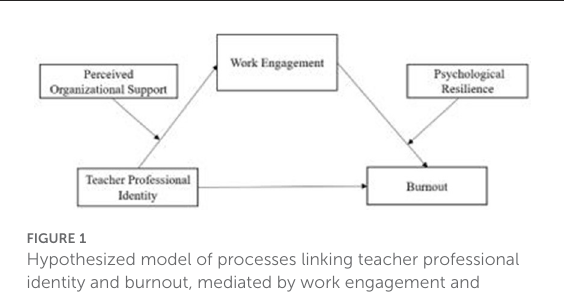
FIGURE1 Hypothesized model of processes linking teacher professional identity and burnout, mediated by work engagement and moderated by perceived organizational support and psychological